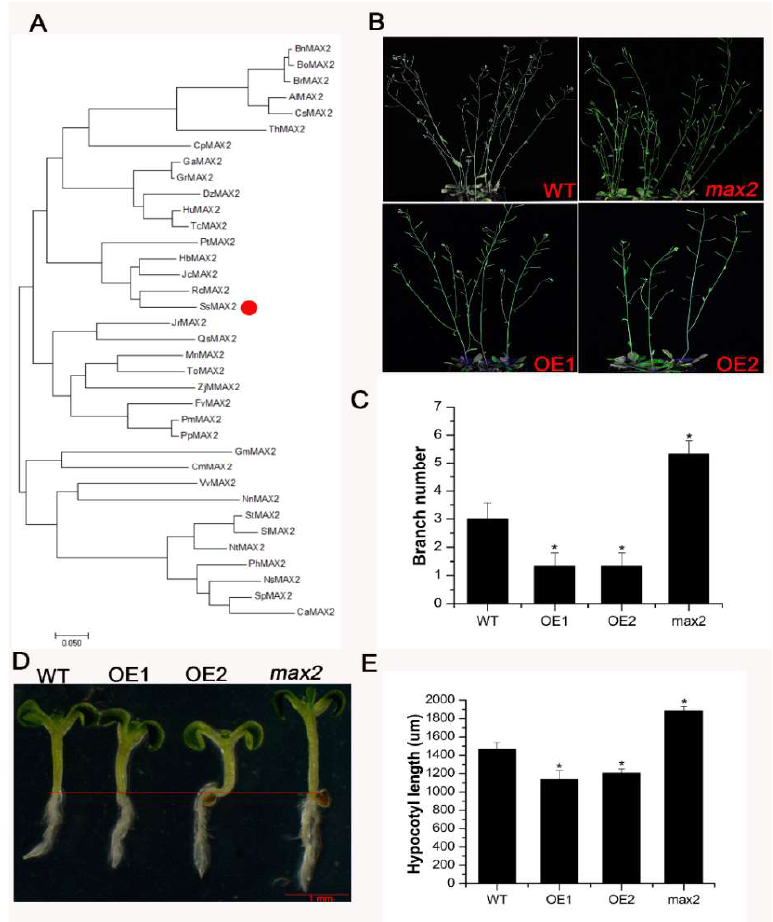
Figure 1. Phylogenetic analysis and functional characterization of SsMAX2 in Arabidopsis . ( A ) Phylogenetic analysis of SsMAX2 with its homologs from other species; ( B , C ) Rosette branching of 30-day-old plants of wild-type (WT), SsMAX2 overexpression1 (OE1), OE2, and max2 ; ( D , E ) Hypocotyl length of 5-day-old seedlings of WT, SsMAX2 OE1, OE2, and max2 in half Murashige and Skoog (MS) medium. Data are presented as means ± SD of 20 replicates. Significant differences were determined by Student’s t -test. Significance level: * p < 0.05.